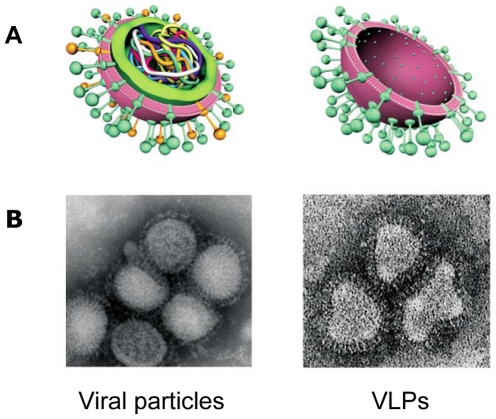
Schematic representation of the structural characteristics of viral particles and plant-made VLPs.A. Cross-section showing internal differences. B. Transmission electron microscopy images of influenza viruses and plant-made VLPs.